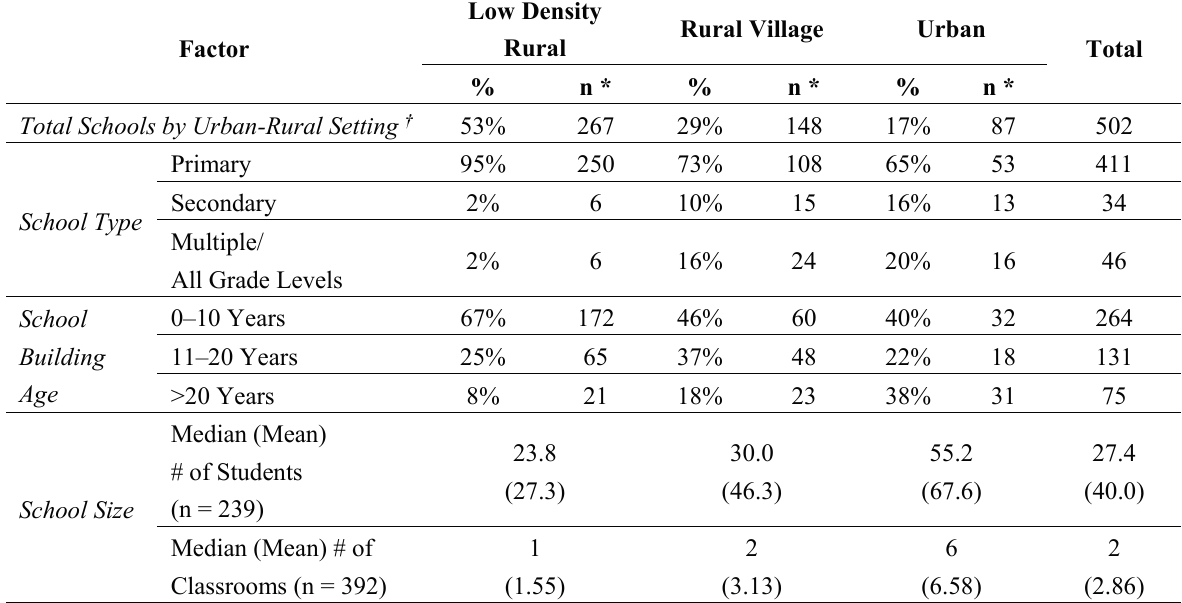
Table 2. School characteristics based on survey responses.